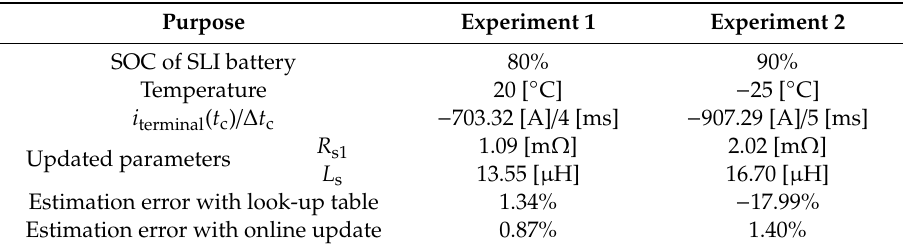
Table 2. Cranking experiments and SOF estimation